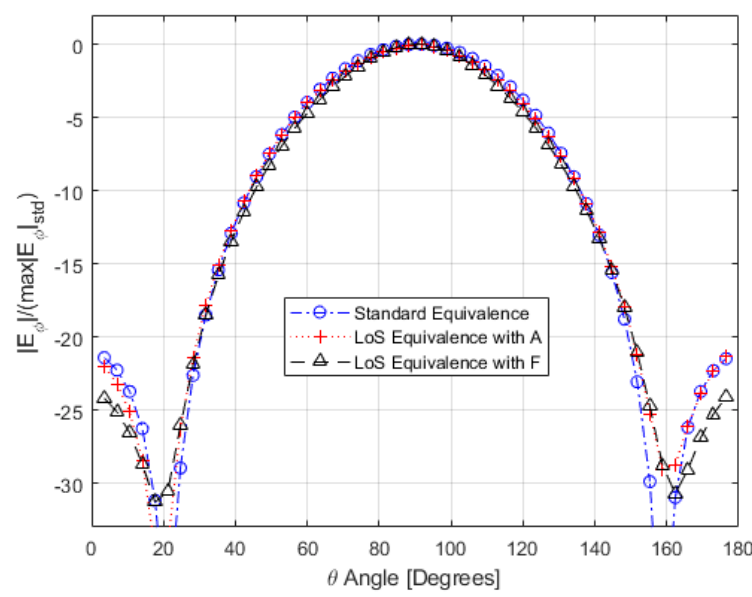
Figure 3. The E-plane co-polarization radiation pattern of the patch antenna.